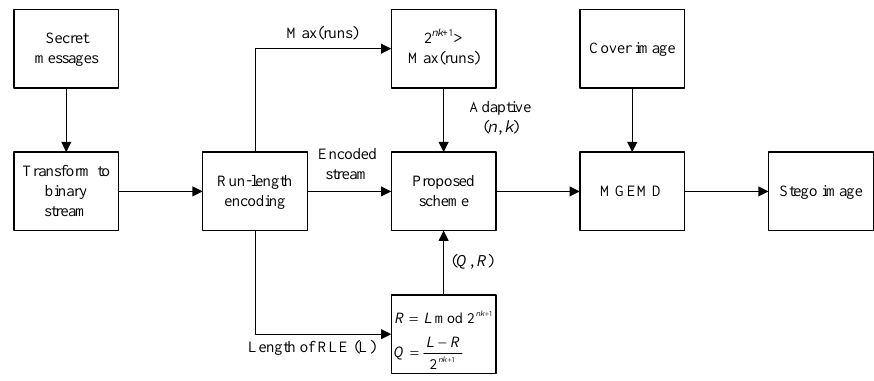
Figure 1. Flowchart of the proposed